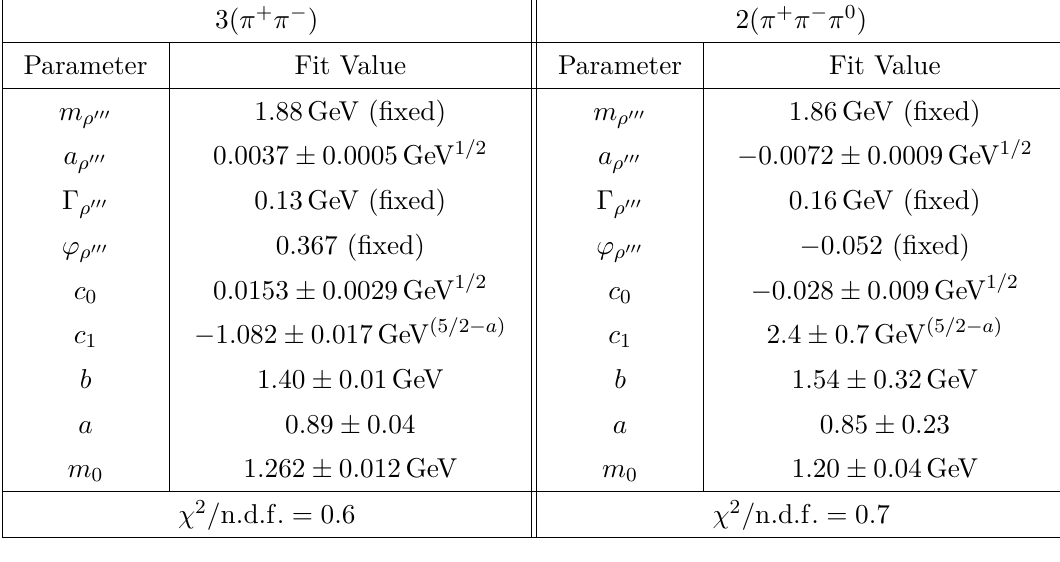
Table 7 . Fit values for the e + e − → 3( π + π − ) current (left) and for the e + e − → 2( π + π − ) π 0 π 0 current (right). The values of m